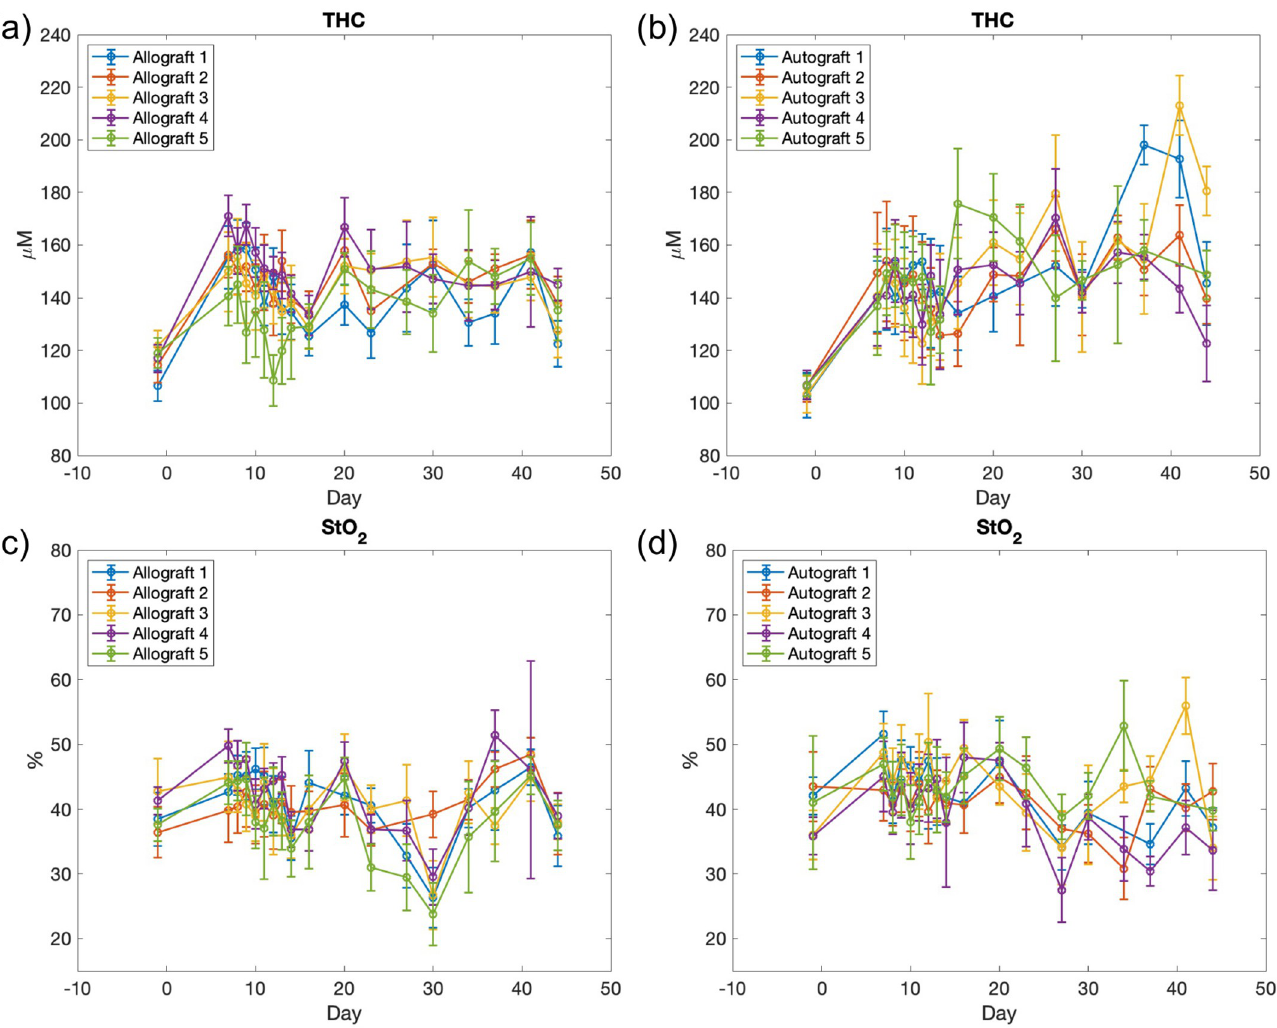
Fig 1. Temporal changes of graft hemodynamic parameters in individual mouse are grouped based on parameter and graft. (a) THC of the allograft group; (b) THC of the autograft group; (c) StO 2 of the allograft group; (d) StO 2 of the autograft group. The error bar indicates the standard deviation of the quantity ( THC or StO 2 ) within the region of